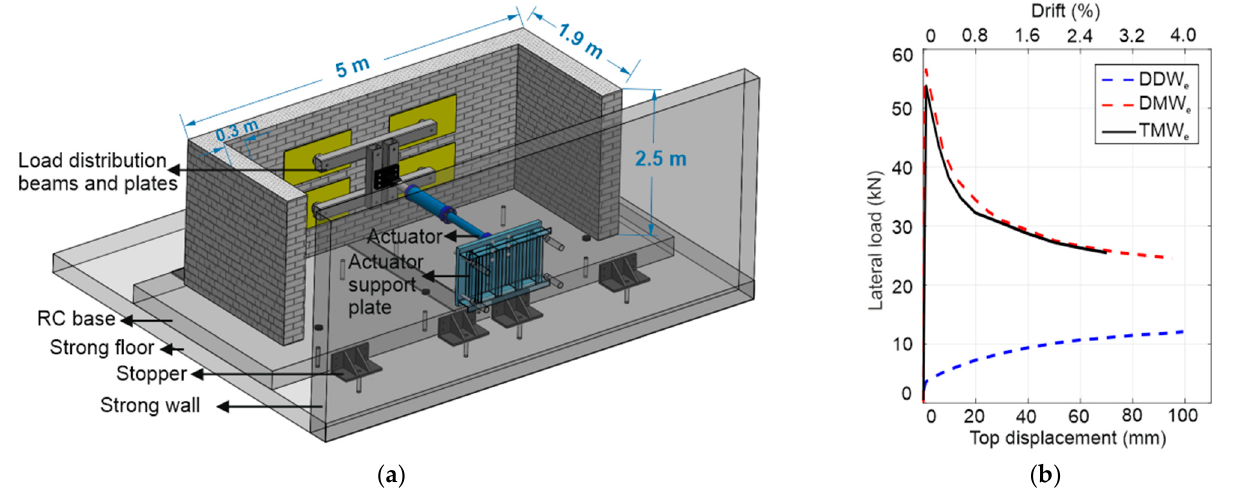
Figure 5. ( a ) OOP test setup, and ( b ) load–drift response of wall specimens.